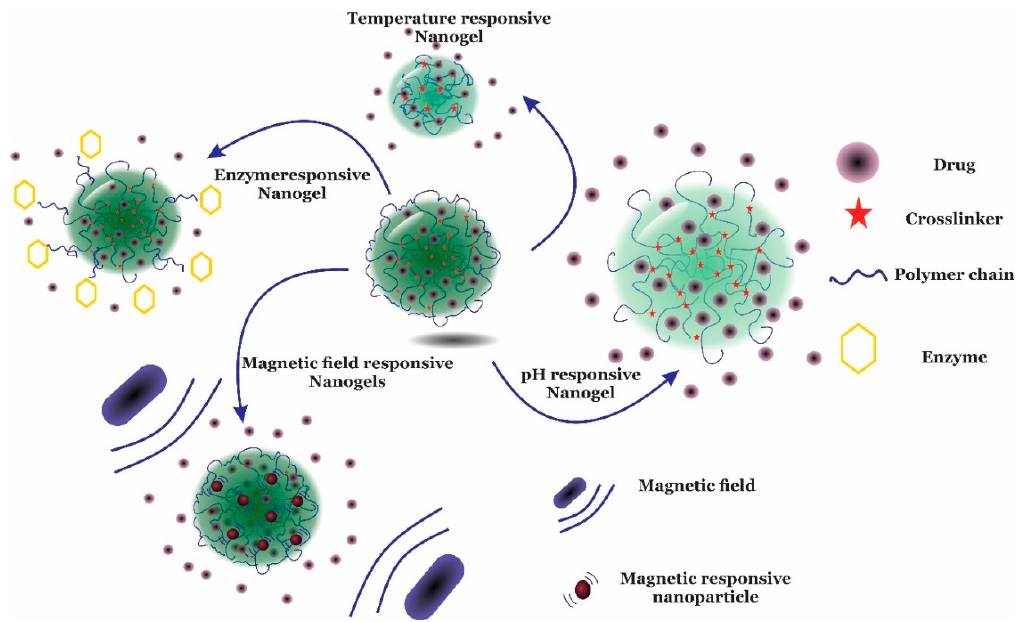
Figure 3. Scheme of different stimuli ‐ responsive nanogels in response to temperature, enzyme, the magnetic field, and pH in drug delivery applications.